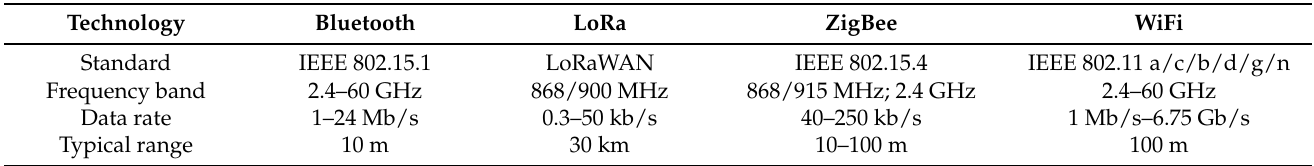
Table 2. Comparative of main Wireless IoT communication protocol: Bluetooth, LoRa, ZigBee, and Wi-Fi. Simplification made from [36]: Table 2.